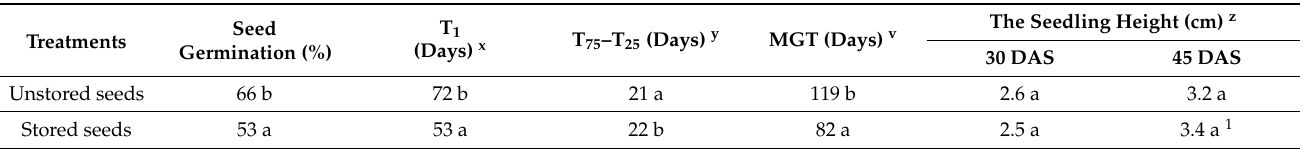
Table 1. Overall effects of unstored seeds and seeds stored at − 18 °C for 6 months on seed germina- tion (%) and seedling height, Skierniewice, Poland, 2019.